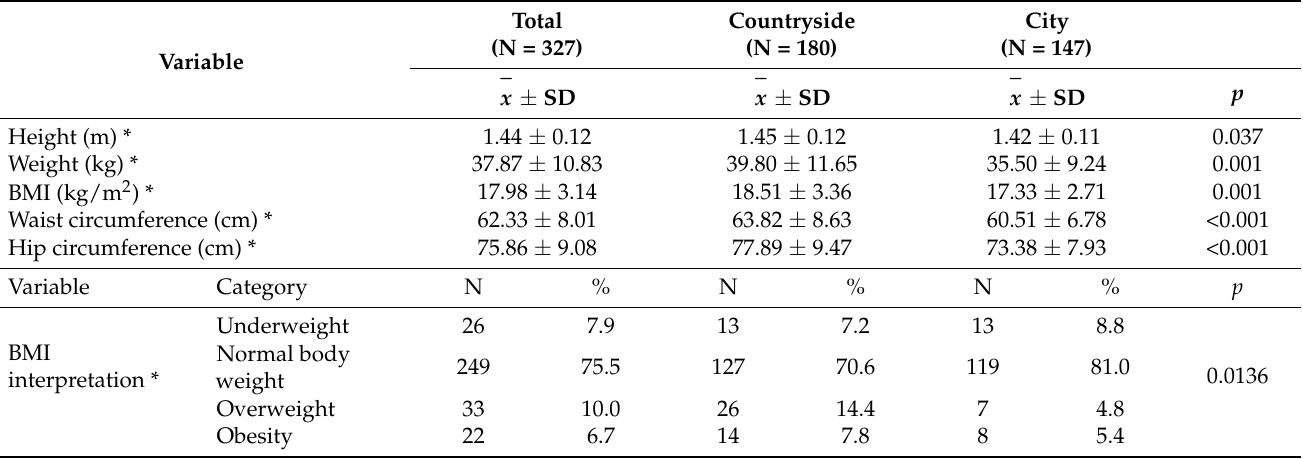
Table 2. Results of anthropometric measurements and interpretations of the BMI index of children according to place of